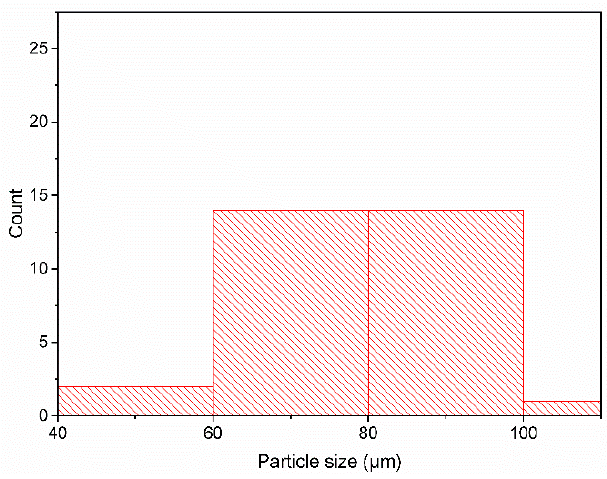
Figure 17. Particle size distribution.